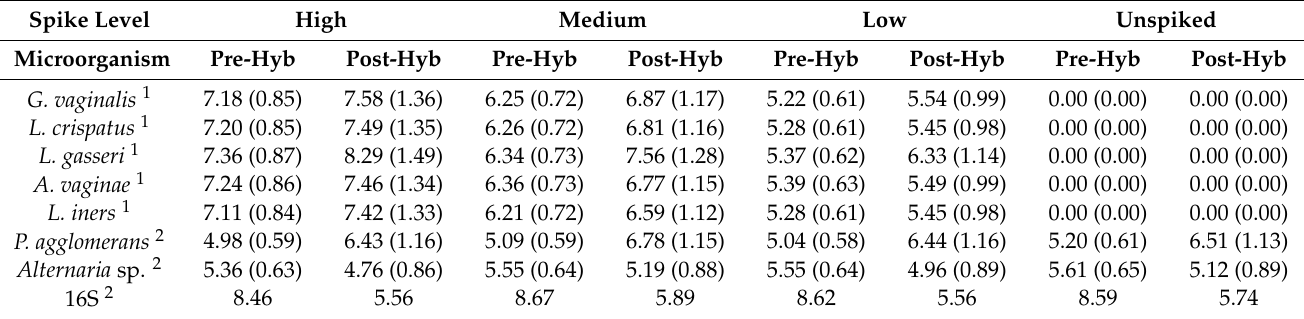
Table 2. qPCR-determined log 10 cpn60 gene copies in wheat seed wash samples spiked with varying amounts of cpn60 plasmids from non-endogenous microorganisms. Two microorganisms previously shown to be associated with the wheat seed microbiota, along with the total number of 16S gene copies (representing non- cpn60 DNA) are also shown. Results are shown prior to hybridization (pre-hyb) and after hybridization (post-hyb). The observed ratio of cpn60 /16S genes is shown in brackets for each target. Spike Level